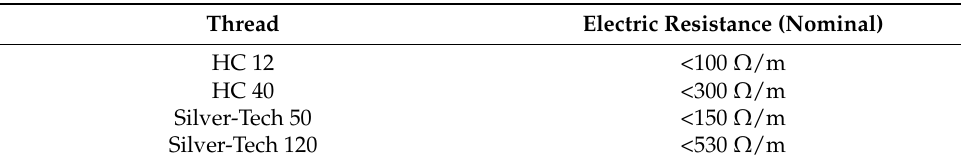
Table 1. Electrical Properties of the Supplied